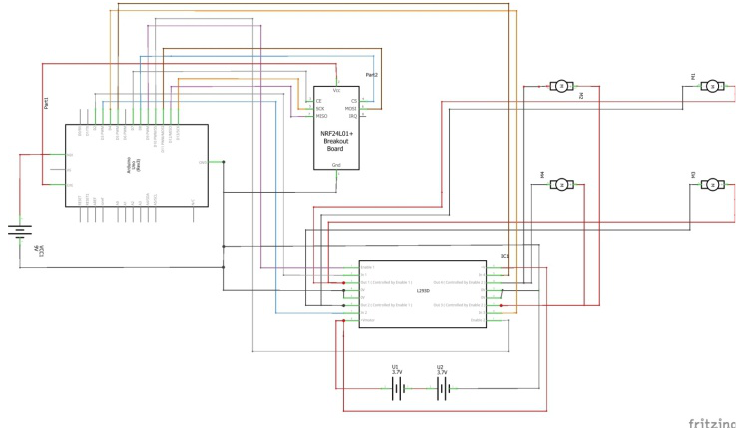
Fig. 15. Schematic diagram of a multipurpose RC vehicle with DC motor